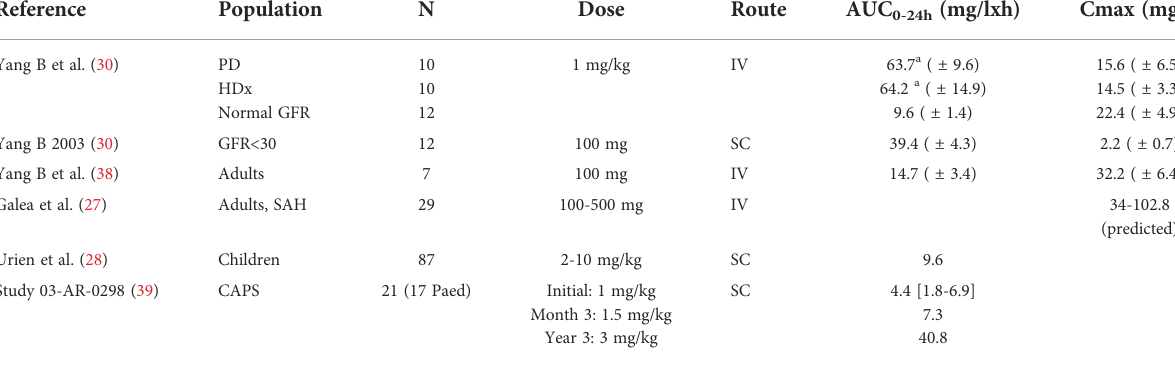
TABLE 1 Example anakinra dose and exposure values from published